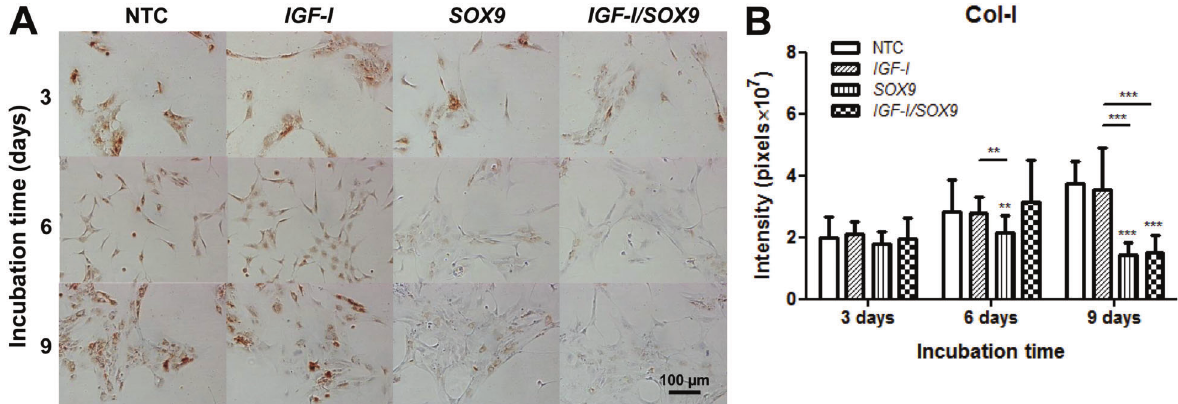
Figure 3. Immunocytochemical detection of Col-I. Speci fi c anti-Col-I primary monoclonal antibodies ( A ) were used to stain the non-transfected human chondrocytes (NTC) and those following transfection with pCMV-SPORT6 IGF-I ( IGF-I ), pCMV-SPORT6 SOX9 ( SOX9 ), or cotransfection with both plasmids ( IGF-I/SOX9 ). Images were taken on days 3, 6, and 9 post-transfection. Once transfected, the cells were incubated at 37°C in a 5% CO 2 atmosphere. Quanti fi ed in situ densitometry is shown in the bar graph ( B ). Data are reported as the average and standard deviation of the densitometry value normalized to the number of cells in the evaluated area (expressed in pixels (cid:1) 10 7 ), which was performed on all chondrocytes observed in 32 images on days 3, 6, and 9 post-transfection. ***P o 0.001 and **P o 0.01 vs NTC; other signi fi cant differences are indicated with lines (two-way ANOVA with Bonferroni post hoc tests).